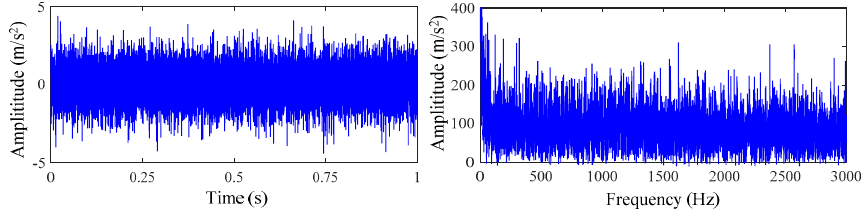
Figure 3. Time-domain plot of simulated signal and corresponding frequency spectrum.